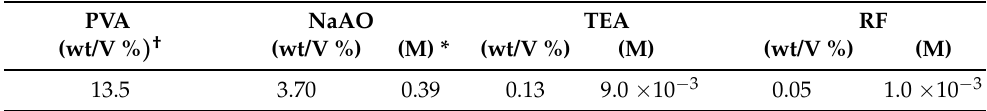
Table 1. Recording material composition